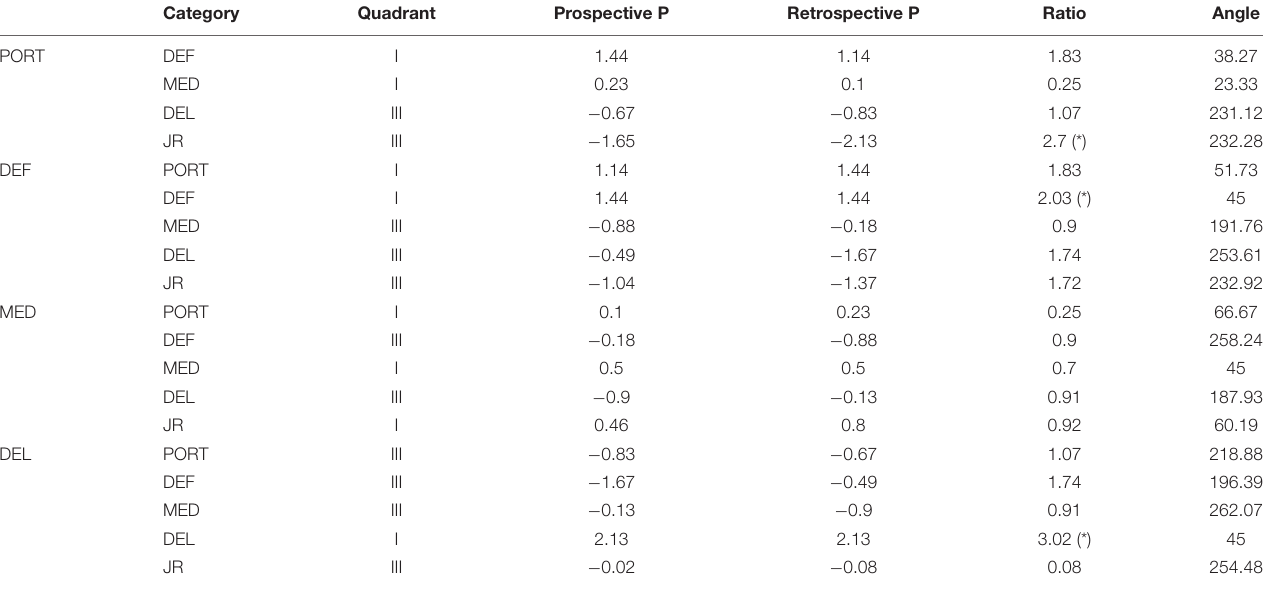
TABLE 14 | Results of the analysis of polar coordinates for the different focal categories in relation to the rest of the lines that make up the game structure of the 2018–2019 season. Category Quadrant Prospective